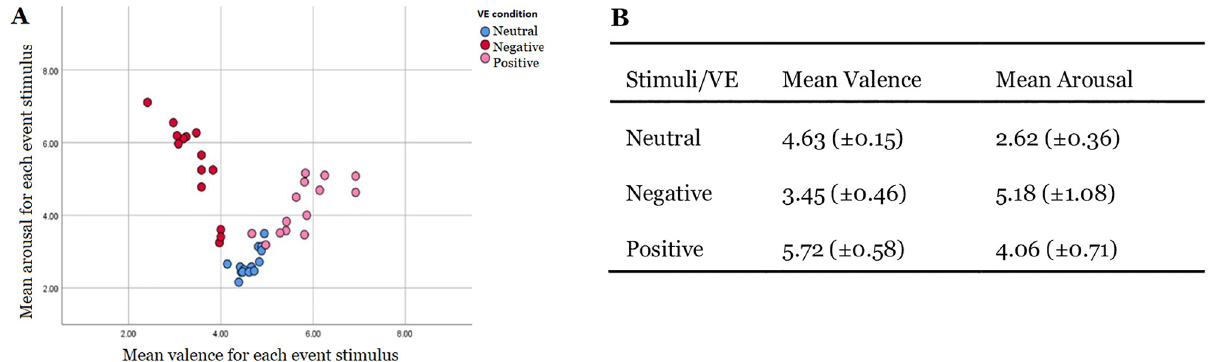
Fig 4. Panel A: Mean valence and arousal ratings for each event/object presented in the three office-based VE conditions. The x-axis (bottom) displays valence ratings and the y-axis (left) displays arousal ratings. Panel B: Mean valence and arousal scores averaged across all events/objects for each VE.